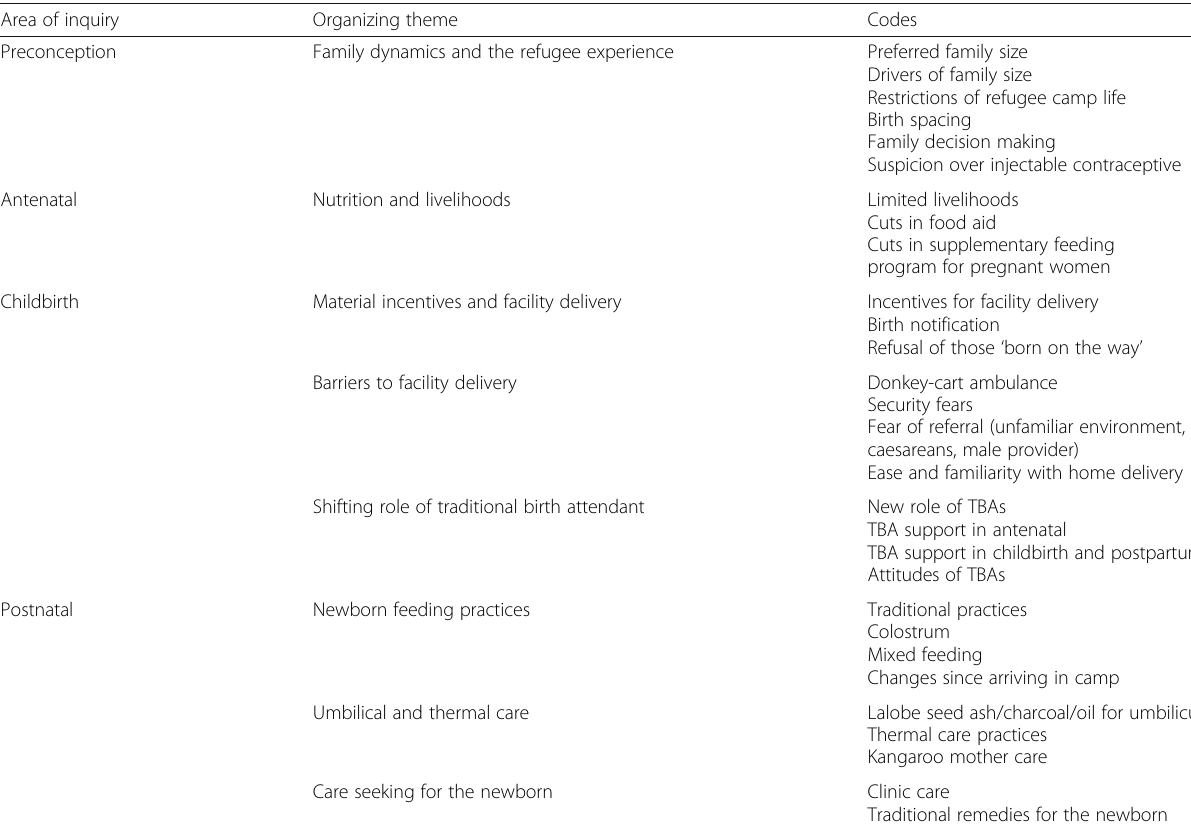
Table 3 Codes, themes, and areas of inquiry Area of